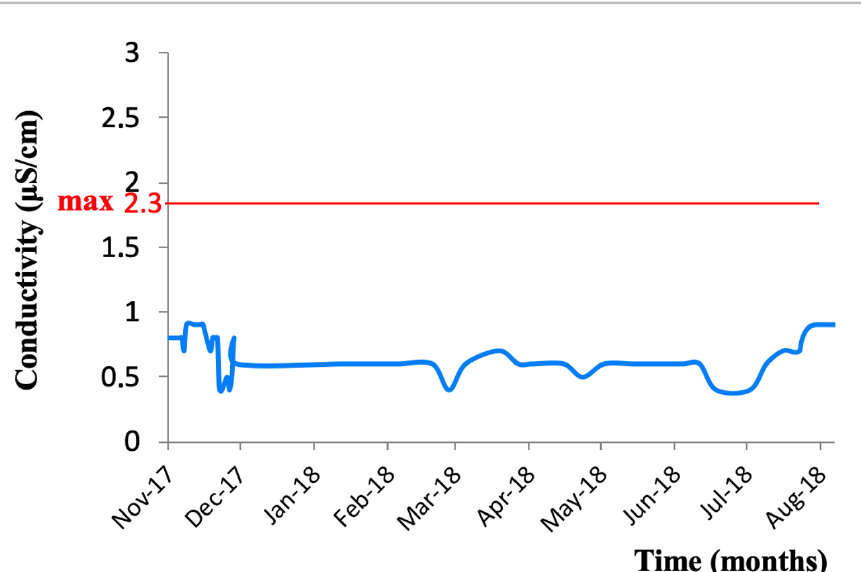
FIGURE 4 - Conductivity monitoring at sampling points after the application of corrective